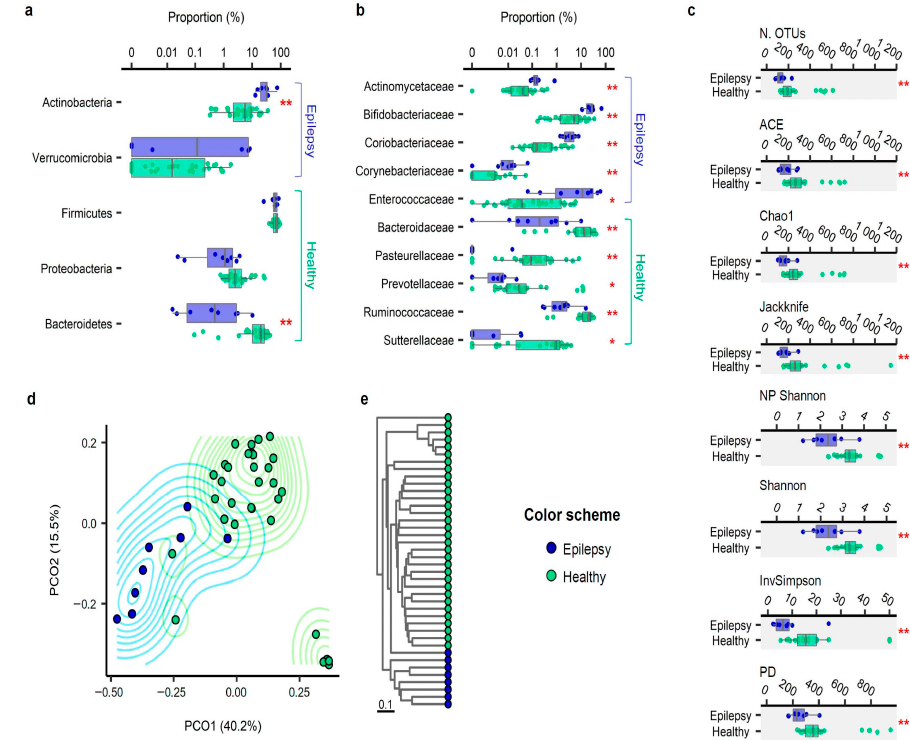
Figure 1. Comparison between the patients with intractable epilepsy and the healthy controls: ( a ) phylum level composi-